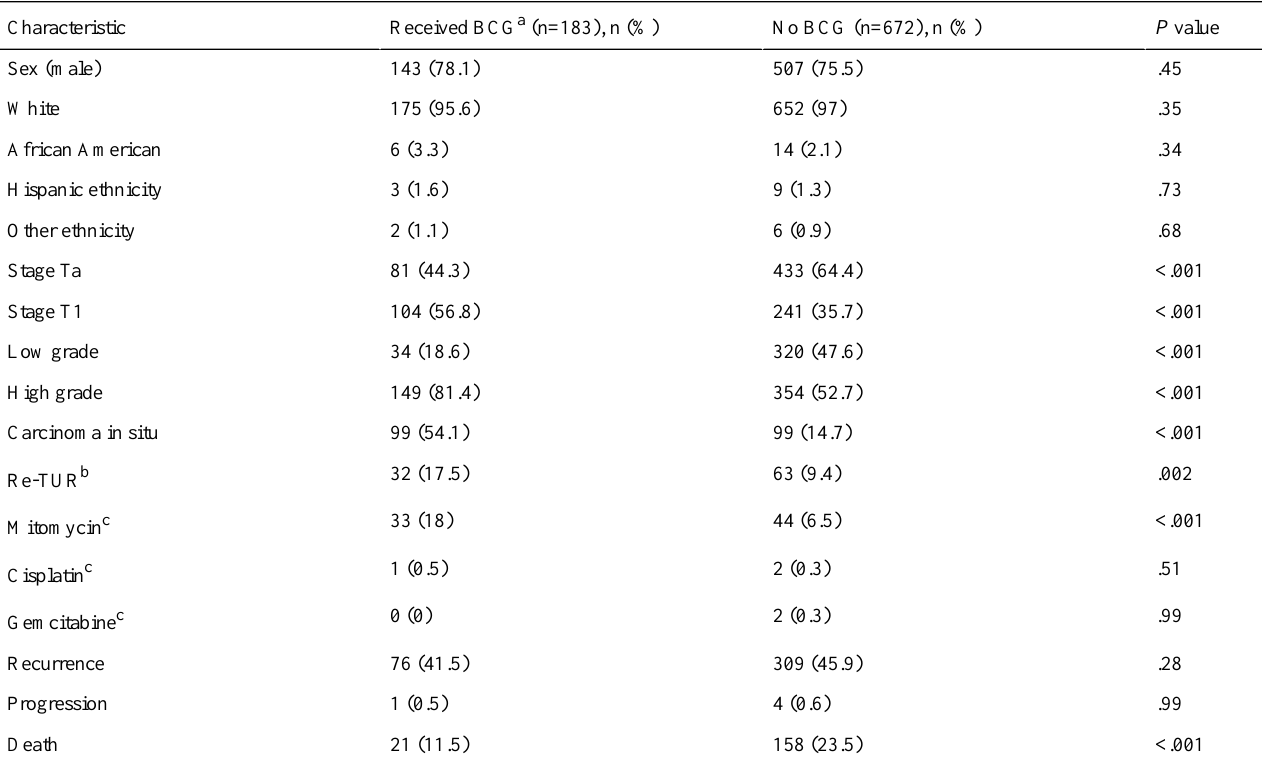
Table 2. Next event and cohort characteristics at the initial transurethral resection of the bladder tumor by bacillus Calmette-Guérin status.